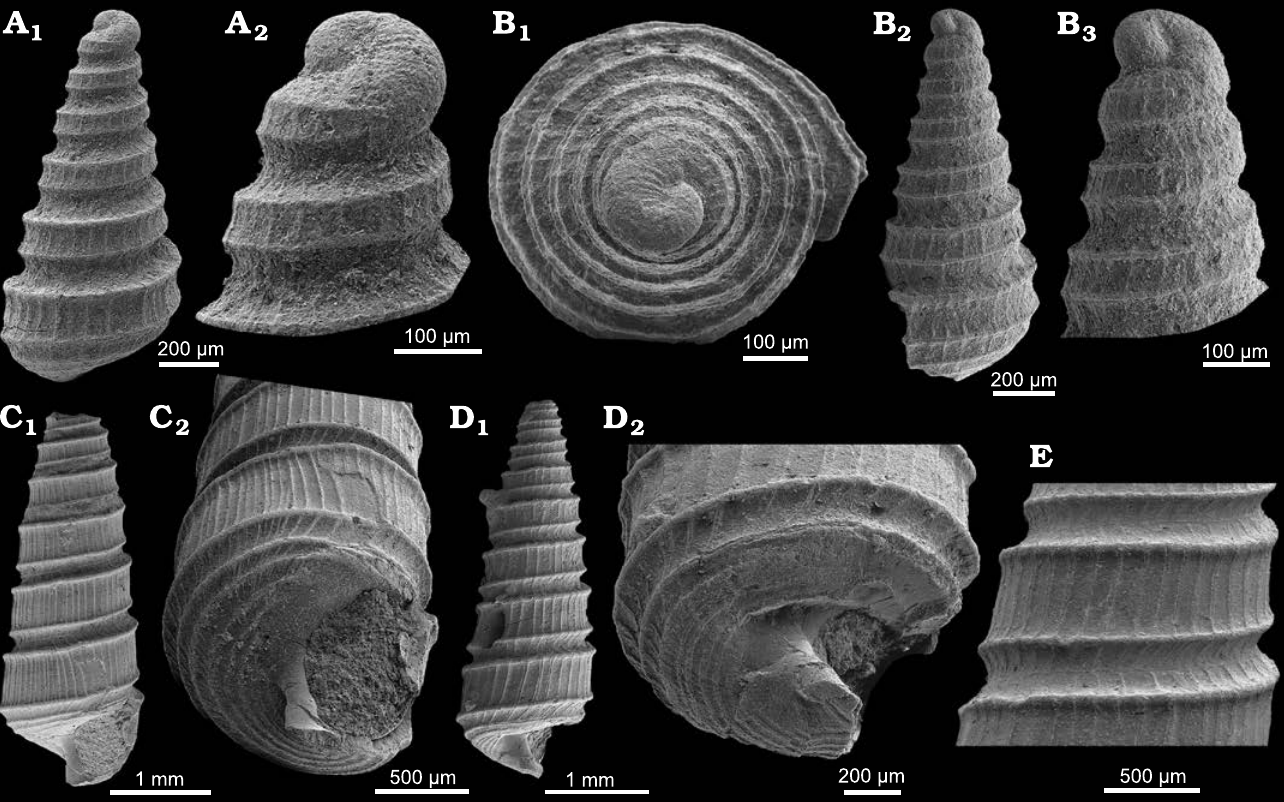
Fig. 20. Mathildid gastropod Jurilda elongata (Leonardi and Fiscon, 1959) from Misurina Landslide, northern Italy, Cassian Formation, Carnian, Upper Triassic. A . PZO 12716, in lateral view (A 1 ), A 2 , early whorls including heterostrophic protoconch, in lateral view. B . PZO 12717, in apical (B 1 ) and lateral (B 2 ) views; B 3 , early whorls including heterostrophic protoconch, in lateral view. C . PZO 12718, in apertural (C 1 ) and oblique basal (C2) views. D . PZO 12719, in lateral (D 1 ) and oblique basal (D 2 ) views. E . PZO 12720, detail teleoconch whorl, in lateral